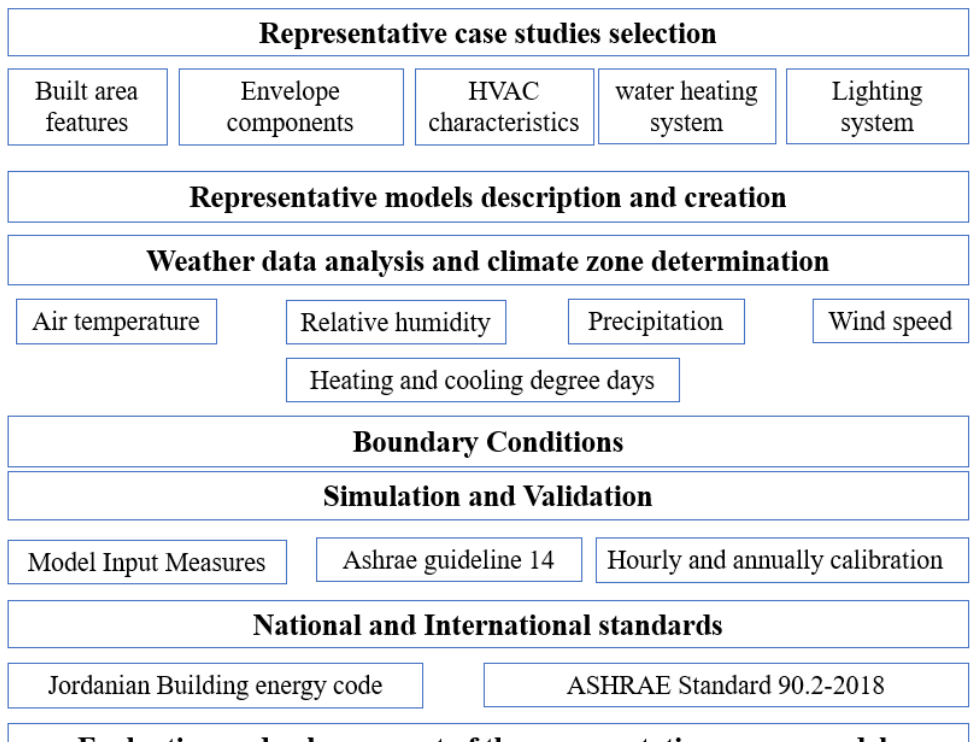
Figure 2. Conceptual study framework.